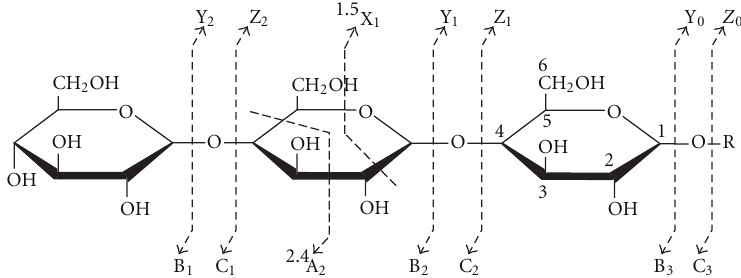
Figure 19: Nomenclature of the product ions formed from the precursor